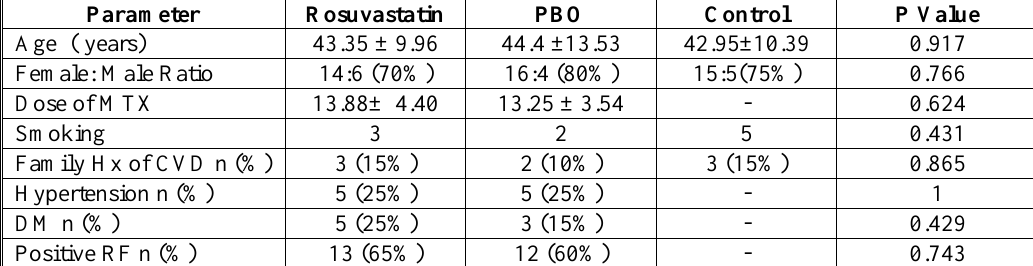
Table ( 1) Demographic data and baseline characteristics of both rheumatoid patients and control subjects